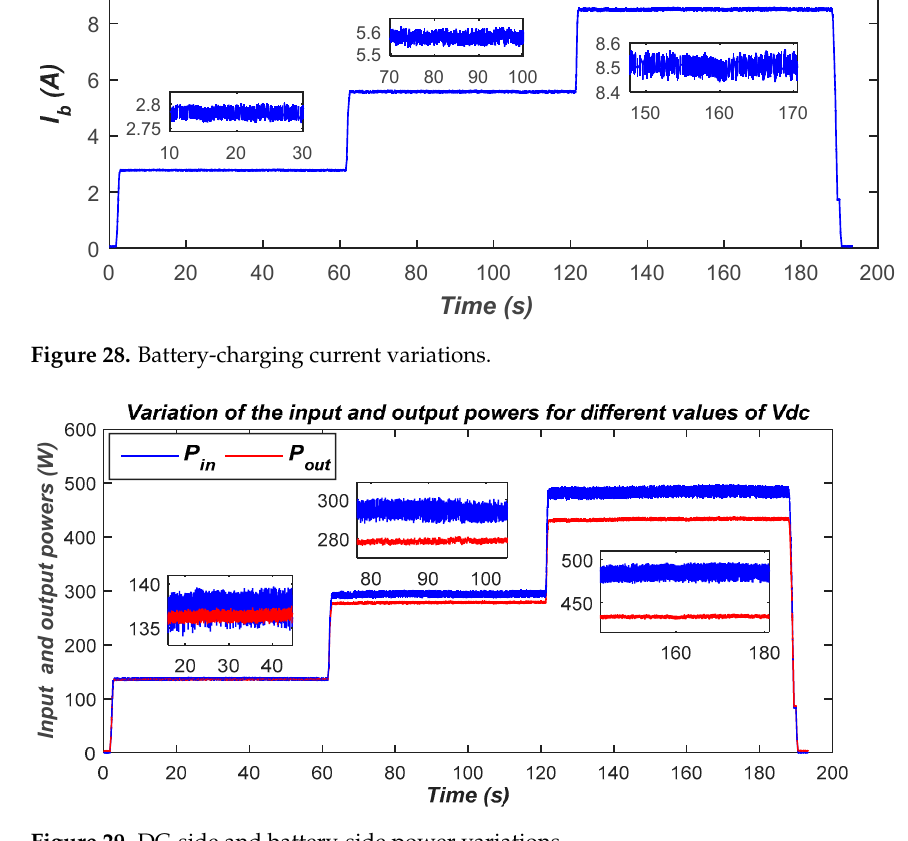
Figure 29. DC-side and battery-side power variations.